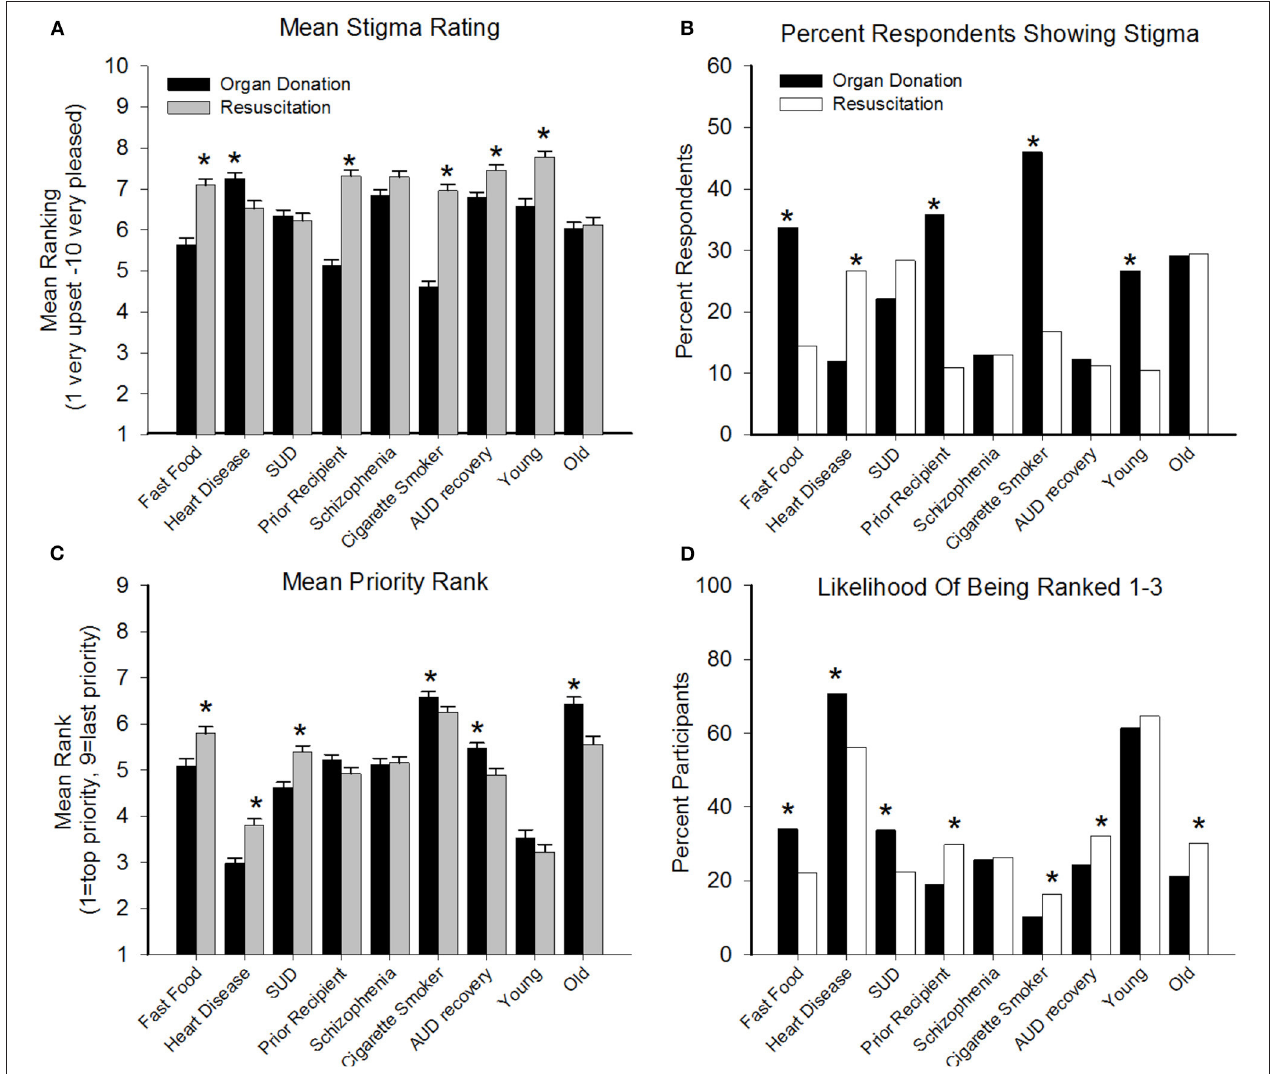
FIGURE 1 | Data present results of acceptability and priority ratings (Y-axes) as a function of the target health conditions (X-axes) with regard to being a recipient of an organ transplant (filled bars) and emergency resuscitation (open/gray bars); dashed lines represent neutral rating threshold or 50% of respondents. ( A , top left) illustrates mean (SEM) acceptability ratings on a scale of 1 (very upset) to 10 (very pleased), with lower values representing greater stigma. ( B , top right) illustrates percent of respondents showing evidence of stigma (defined as rating of 0–4) for the target conditions, with higher values representing greater stigma. ( C , bottom left) illustrates mean (SEM) priority rank from 1 (top priority) to 9 (last priority), with higher numbers representing greater stigma. ( D , bottom right) illustrates percent of respondents who ranked the target health condition in the top three most worthy of receiving access to outcome. Pairwise comparison of continuous variables (A,C) conducted with Bonferroni-corrected t -tests and for (B,D) with Bonferroni-corrected Wilcoxon signed-rank tests, *denotes significant pairwise comparisons p < 0.005. SUD, substance use disorder; AUD, alcohol use